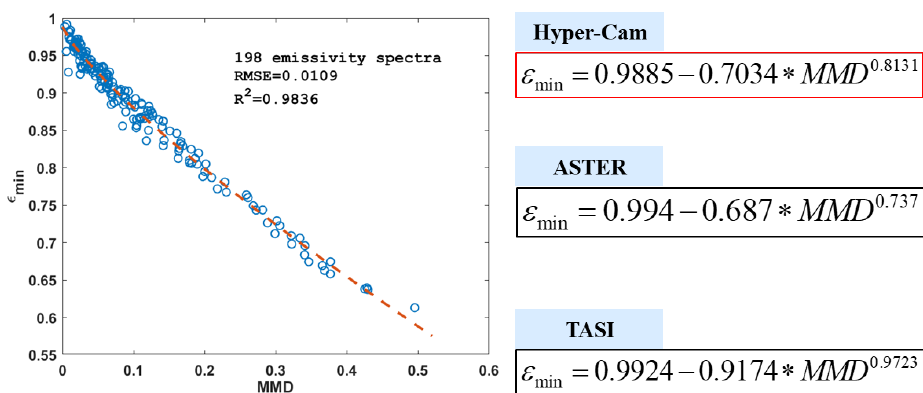
Figure 11. The fitting results for the relationship between the MMD and the minimum emissivity for Hyper-Cam LW field data.